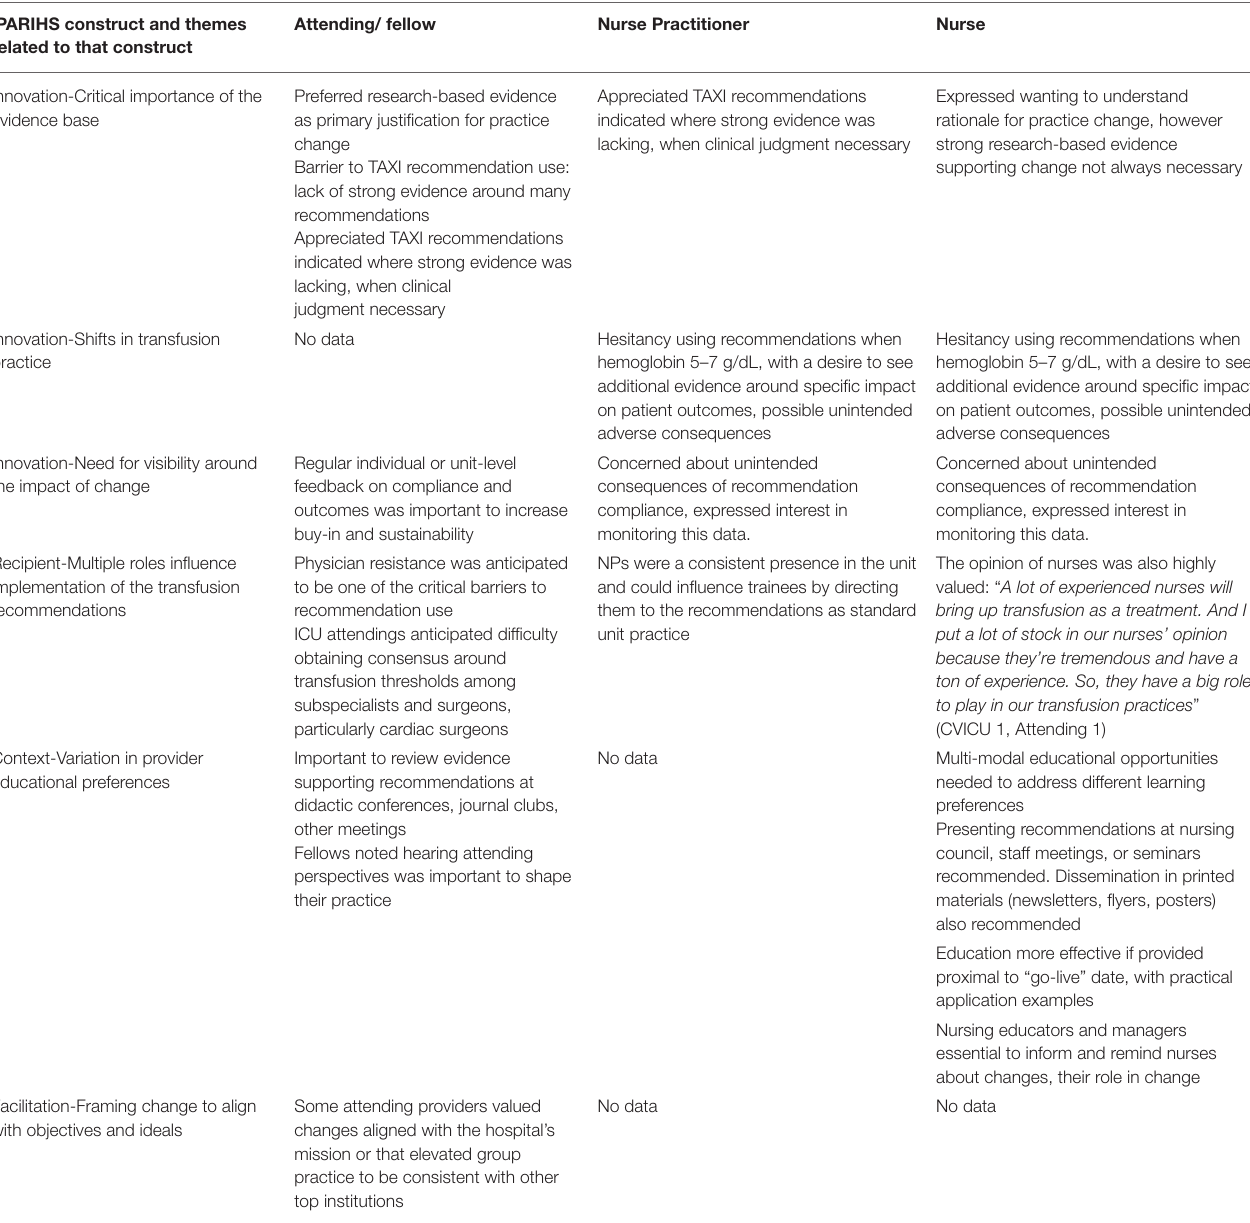
TABLE 2 | Differences in iPARIHS constructs by professional